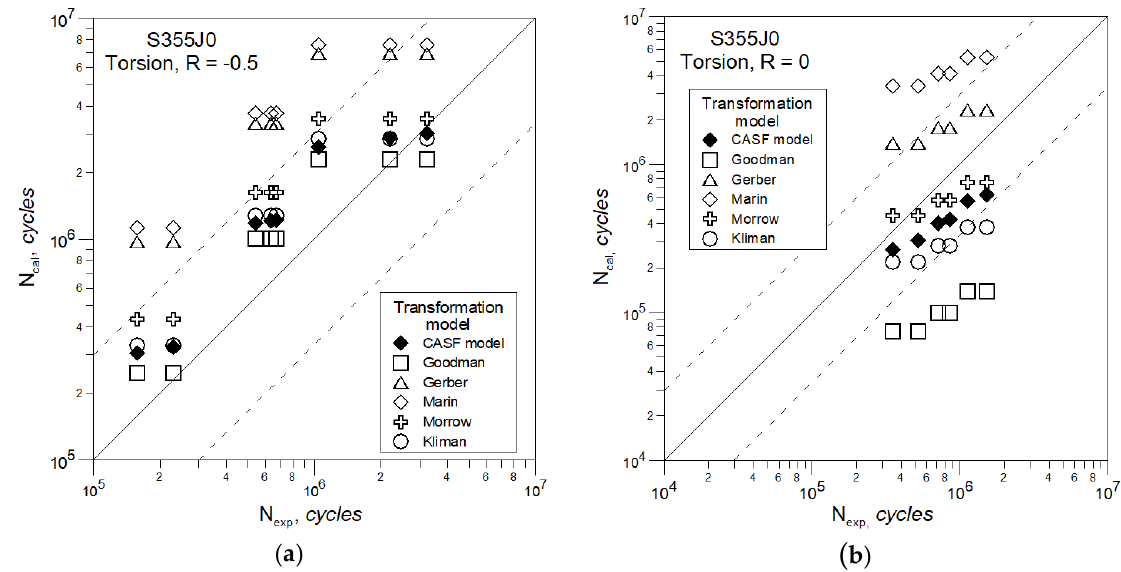
Figure 8. Comparison of the computational life N cal with the experimental N exp under bending for: ( a ) R = −0.5, ( b ) R = −0.